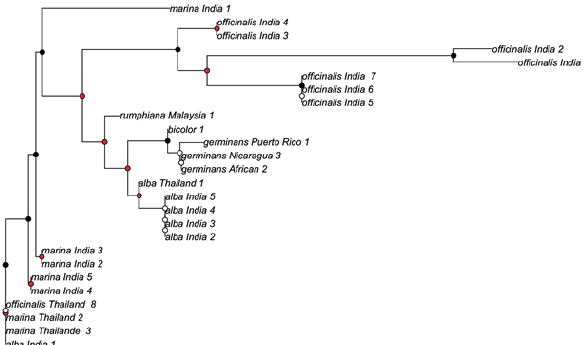
Figure 3. Monophyly analysis of Avicennia species based on trn- HG-psbA sequences. a The red circles on the nodes indicate that the clade is significant at p = 0.05.